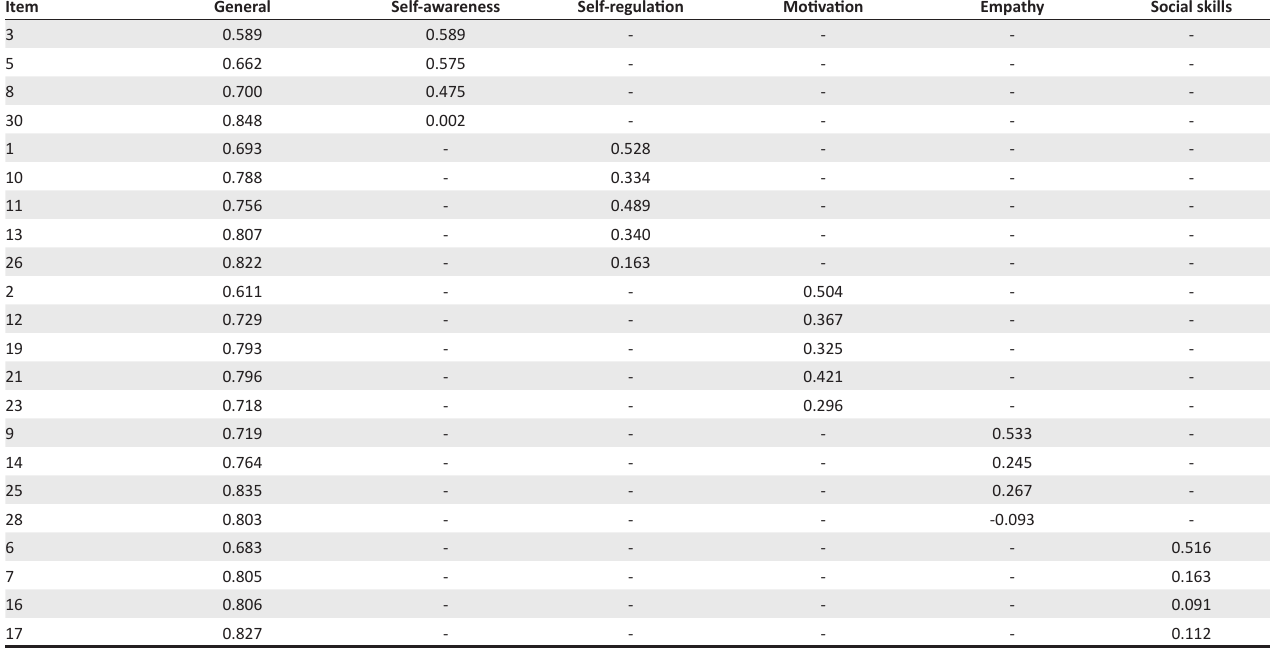
TABLE 7: Bifactor model - Standardised solution (Sample 2, n = 308).